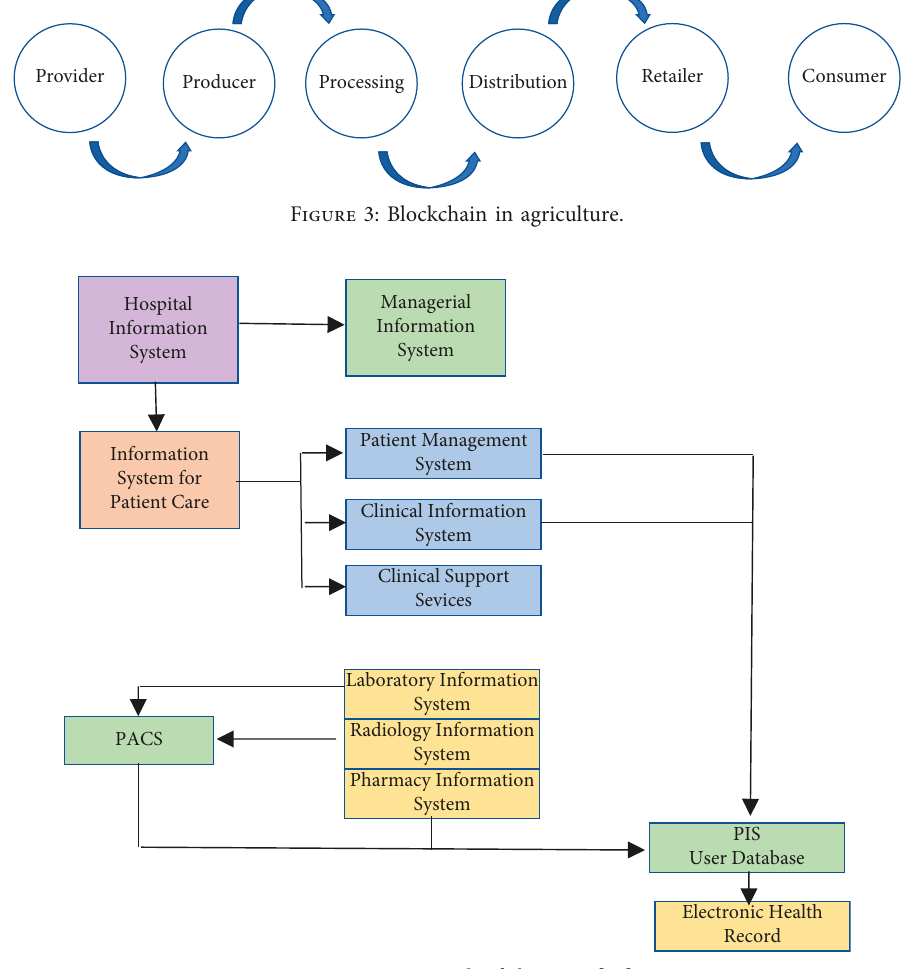
Figure 4: Framework of the EHR